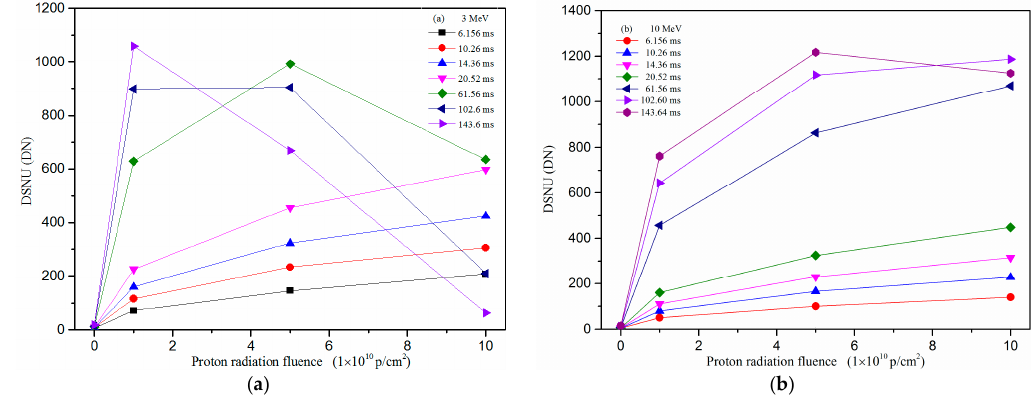
Figure 6. Dark signal distributions of CISs after proton irradiation: ( a ) proton energy: 3 MeV; and ( b ) proton energy: 10 MeV.